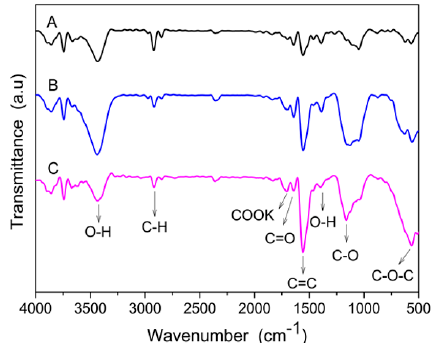
Figure 4. FTIR spectra of pristine and surface modified MWCNTs: ( A ) Pristine CNT, ( B ) A-CNT, ( C ) K-CNT.